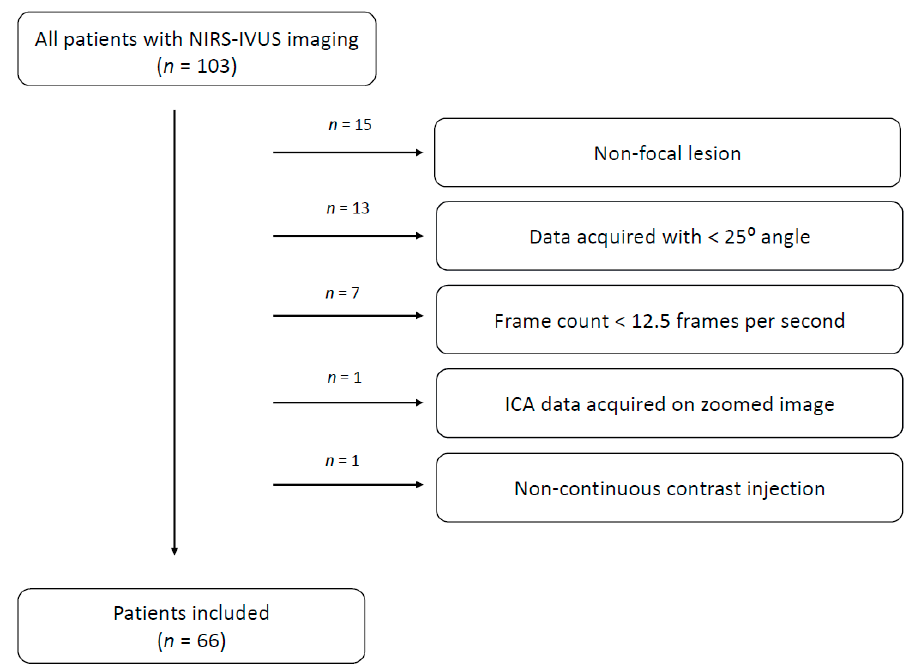
Figure 1. Flowchart of patient selection.